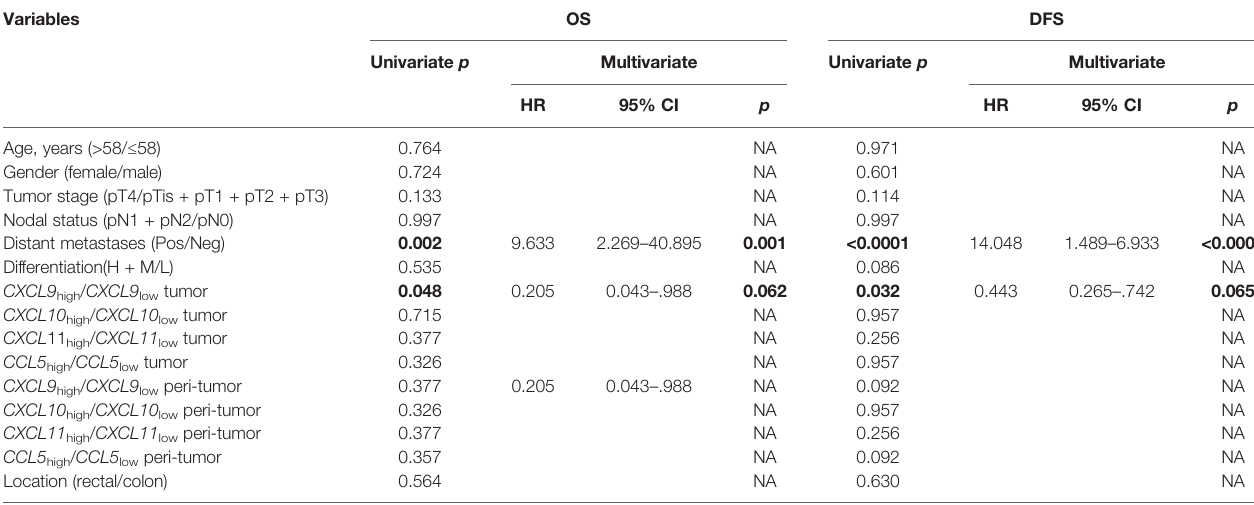
TABLE 2 | Univariate and multivariate analyses of factors associated with survival and recurrence.